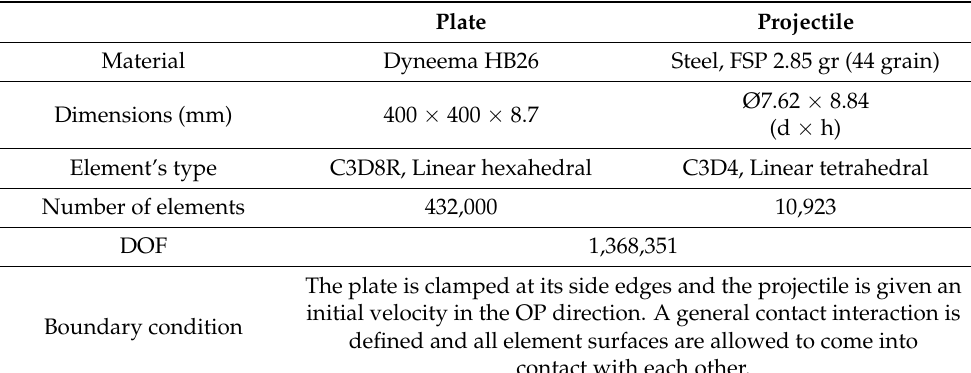
Table 5. Summary of the FEA model’s data.